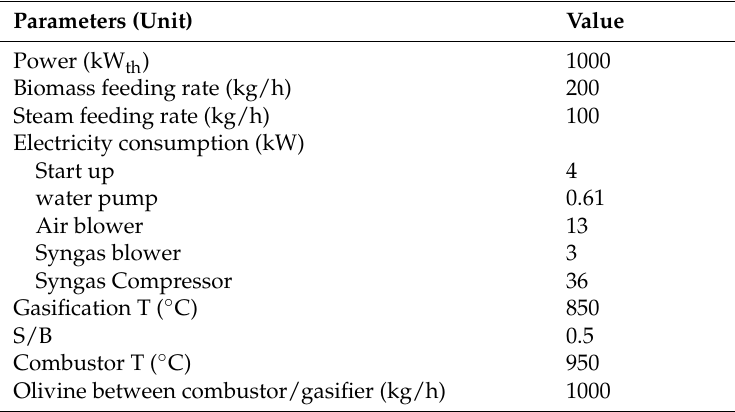
Table 2. Operating conditions of the gasifier.